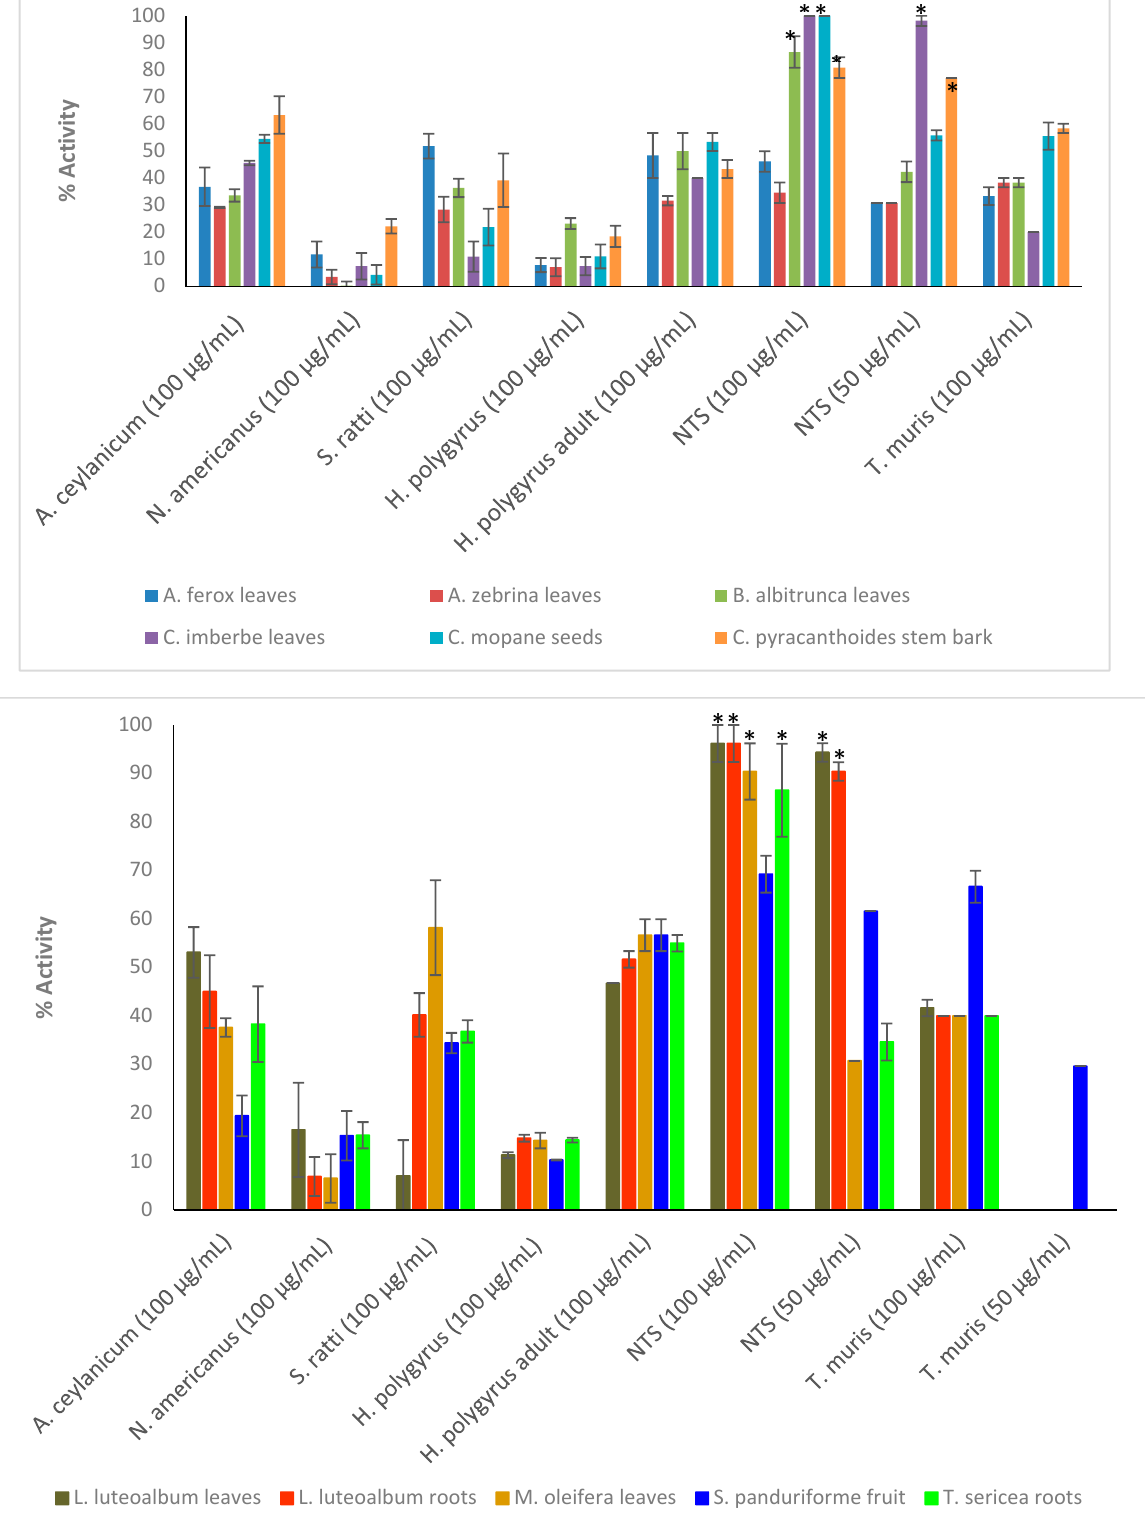
numerical data). Only the most active extracts against NTS (threshold 70% at 50 µg/mL) (Figure 2) were further tested against adult Schistosoma mansoni beginning at 50 µg/mL (Figure 3). Activity above 50% at a concentration of 100 µg/mL for a plant extract is con- sidered relevant [36,37]. Therefore, activity at a concentration of 100 µg/mL above 65% was considered ‘good’, between 30 – 65% ‘moderate’ and below 30% ‘weak’.